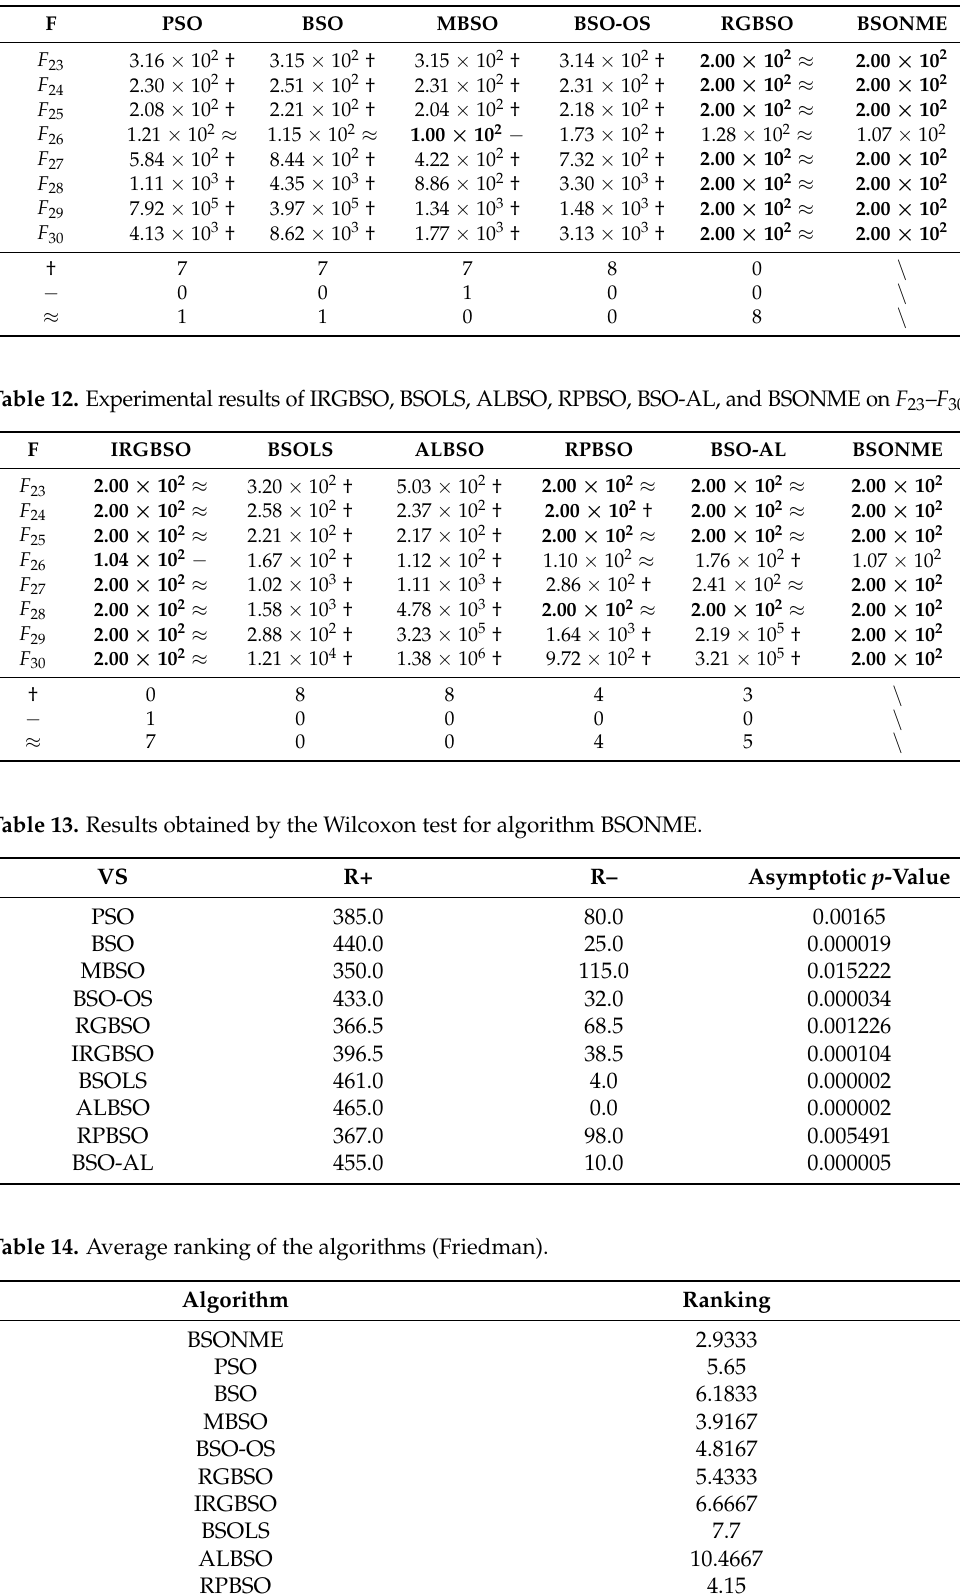
Table 11. Experimental results of PSO, BSO, MBSO, BSO-OS, RGBSO, and BSONME on F 23 – F 30 .